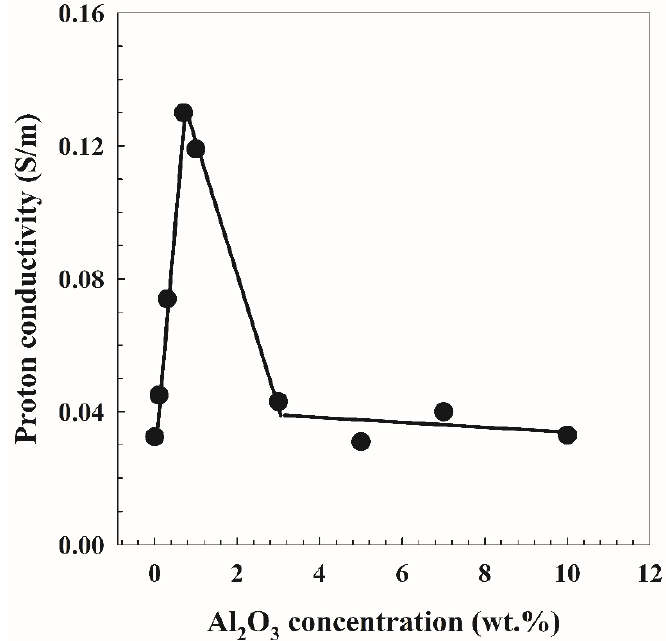
Figure 9. The proton conductivity as a function of the concentrations of Al 2 O 3 on PVA/10 wt.% PEG/20 wt.% SSA membranes.